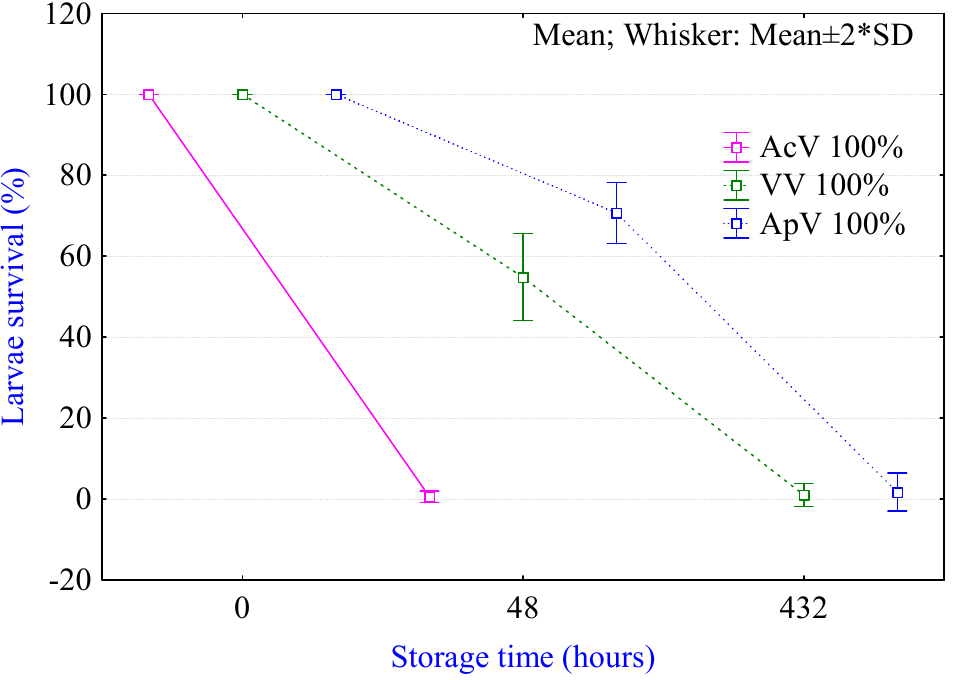
Figure 3. Survival of Anisakis spp. larvae exposed directly to alcohol (AcV 100%), wine (VV 100%) and apple vinegar (ApV 100%).